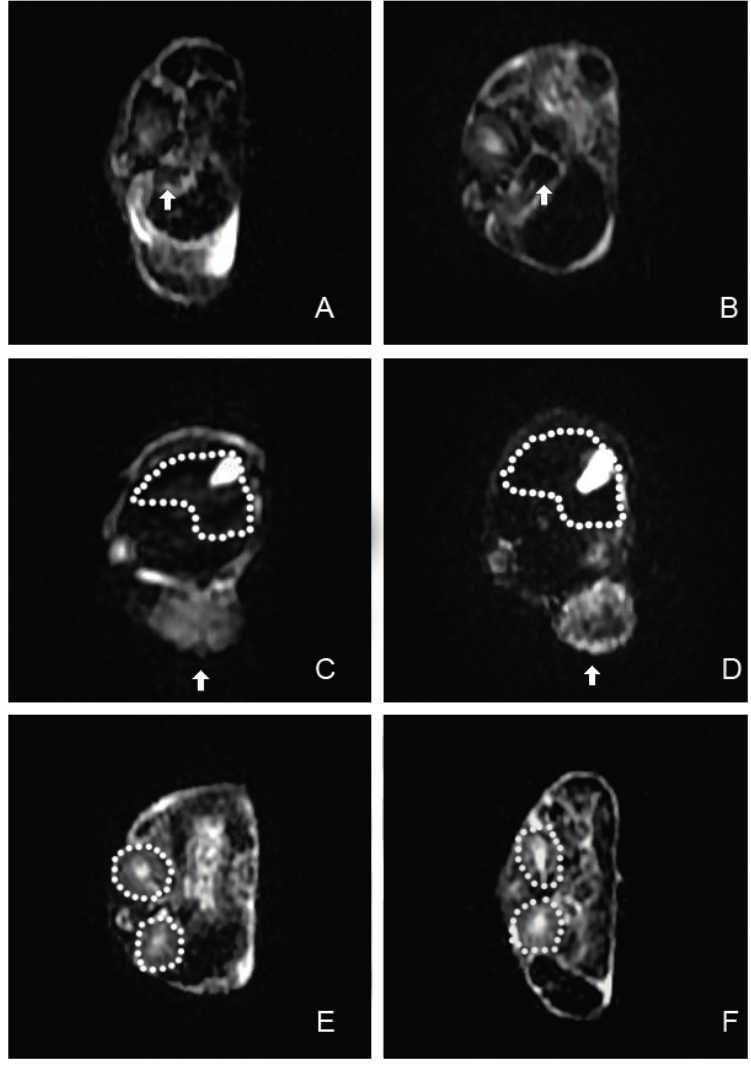
Figure 5. In vivo MRI images of the spleen, liver, and kidney. ( A , B ) T2 weighted images of the spleen (arrows) before SPIONs injection and 6 h post-injection; ( C , D ) T2 weighted images of the liver (dash line) before SPIONs injection and 6 h post-injection. Arrows indicated LNCaP xenograft tumor; ( E , F ) T2 weighted images of the kidney (dash line) before SPIONs injectionand 6 h